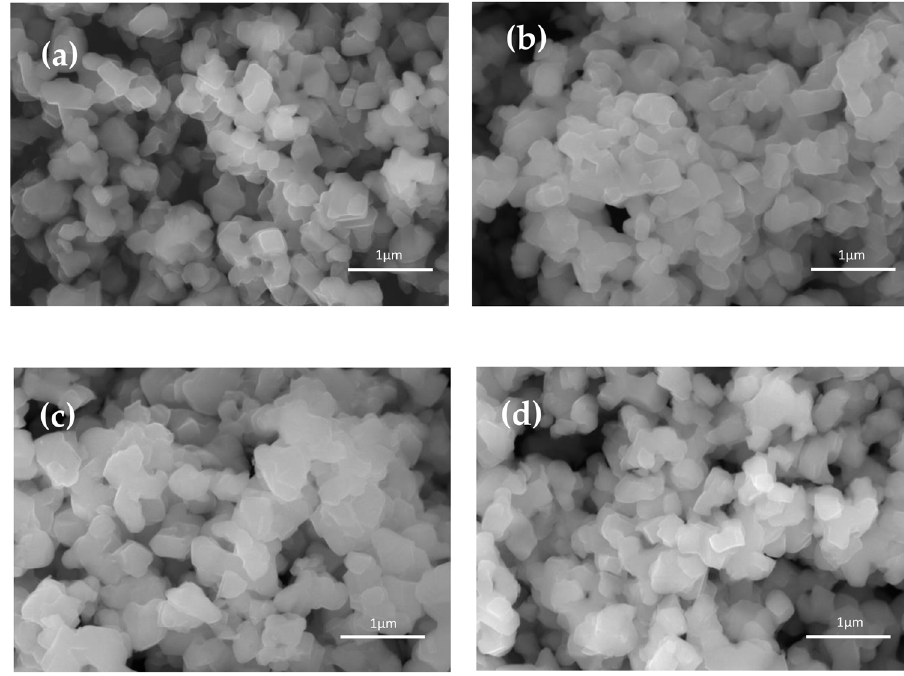
Figure 2. SEM images of ( a ) pristine LTO, ( b ) 0.1 LTO, ( c ) 0.15 LTO, and ( d ) 0.2 LTO.